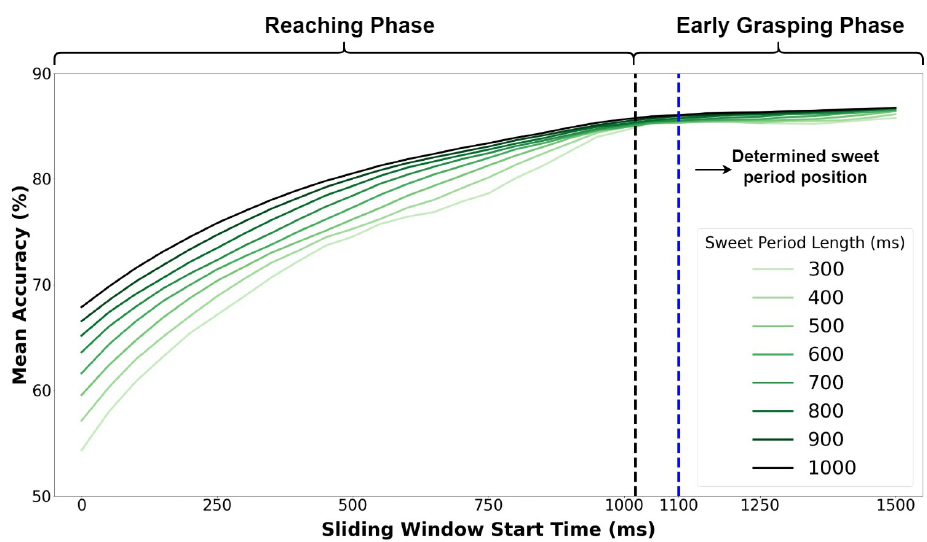
Figure 4. Mean accuracy with different sweet period lengths at different start time.